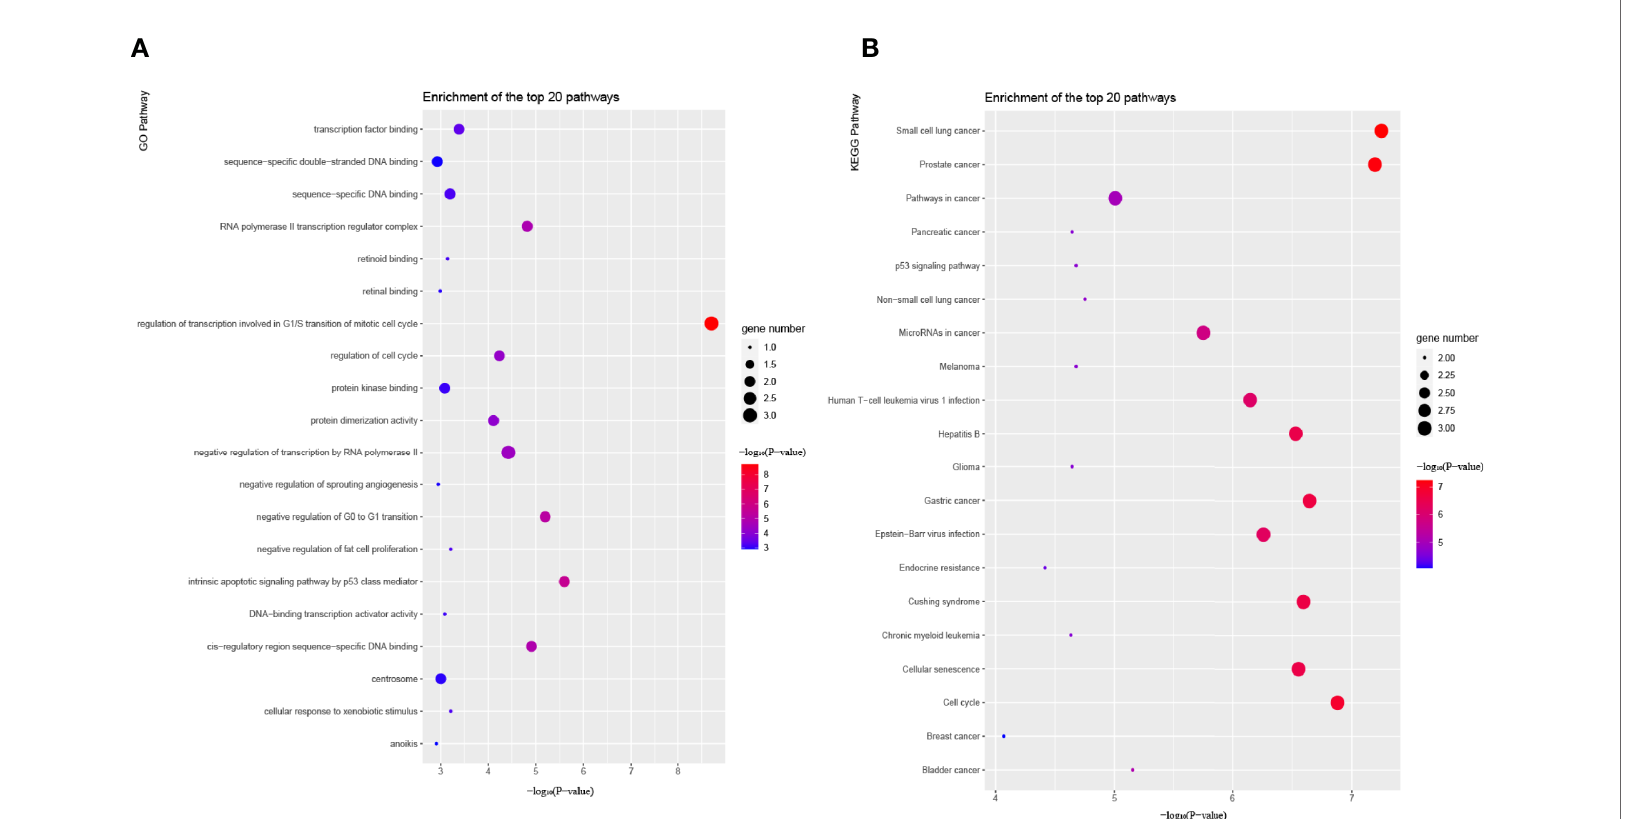
FIGURE 11 | Functional enrichment analysis of candidate hub genes in the network. (A) Bubble plot of GO pathways. (B) Bubble plot of KEGG pathways. GO and KEGG pathway analysis show the potential functions of candidate hub